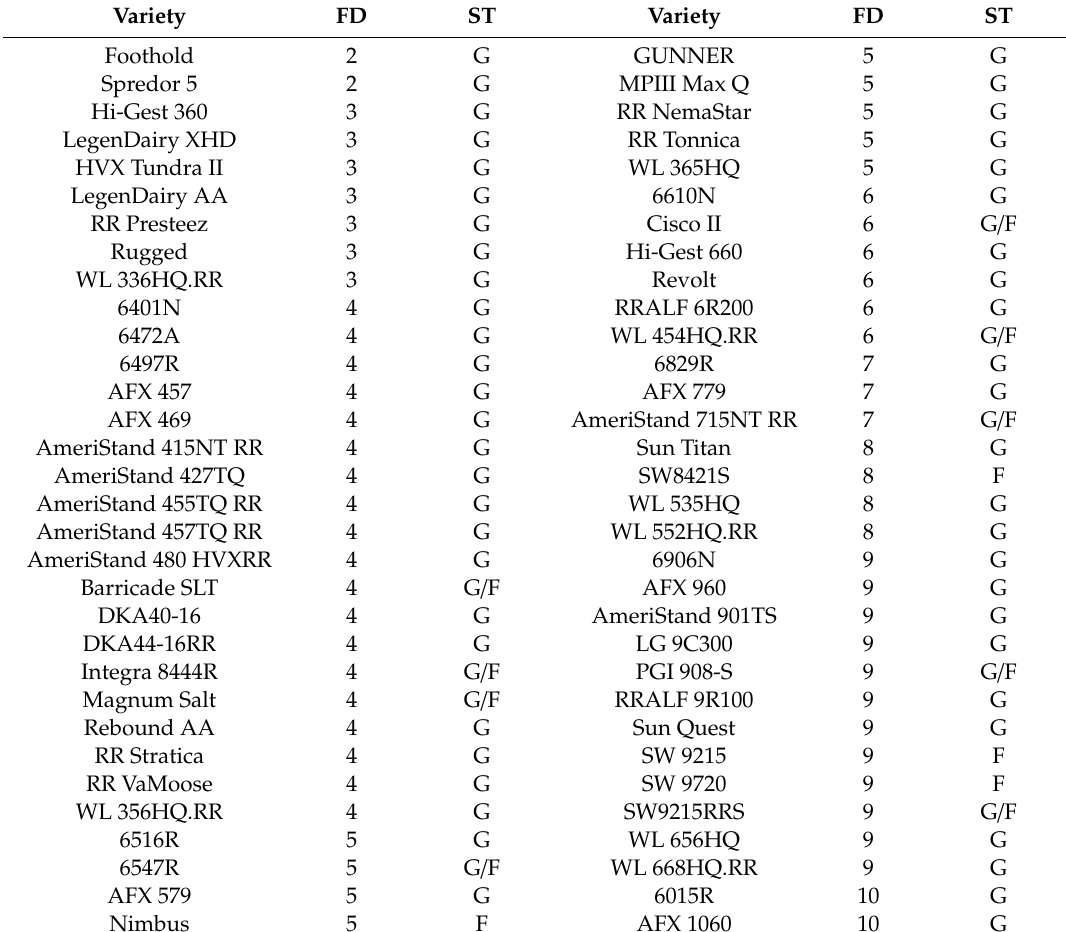
Table 2. Salt-tolerant alfalfa cultivars and their fall dormancy (FD) and growth stages (G, germination and / or F, forage production) for salt tolerance (ST) (Source: National Alfalfa & Forage Alliance,